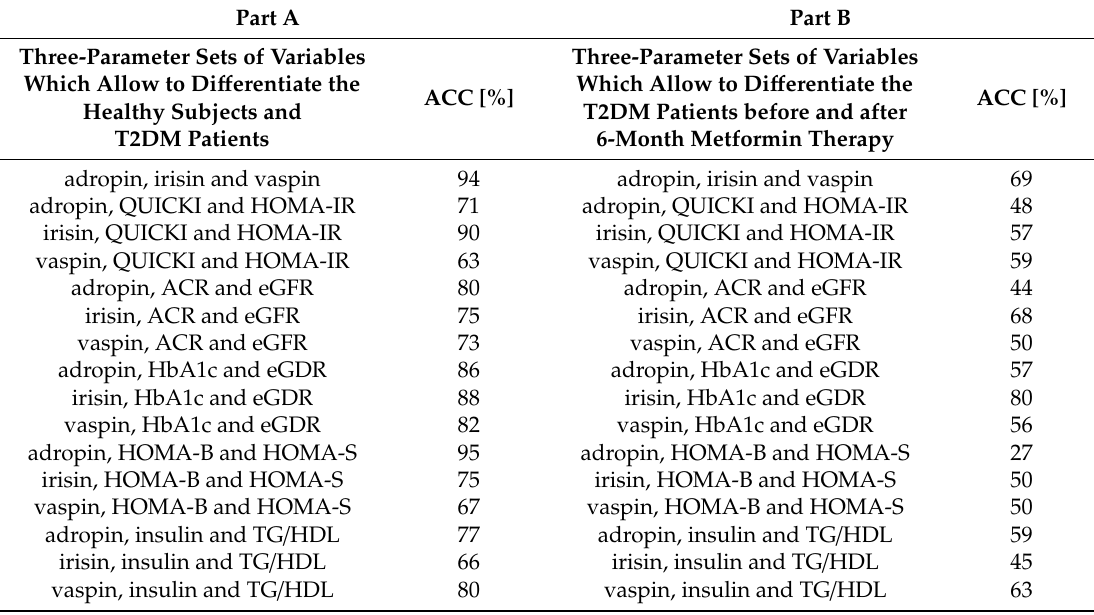
Table 4. Accuracy for three-parameter discriminant analysis which allows to di ff erentiate the patients with metabolically compensated obesity and Type 2 diabetes (T2DM) obese patients (Part A), as well as T2DM obese patients before and after 6-month metformin therapy (Part B), based on adropin, irisin or vaspin values and selected variables. Part A Part